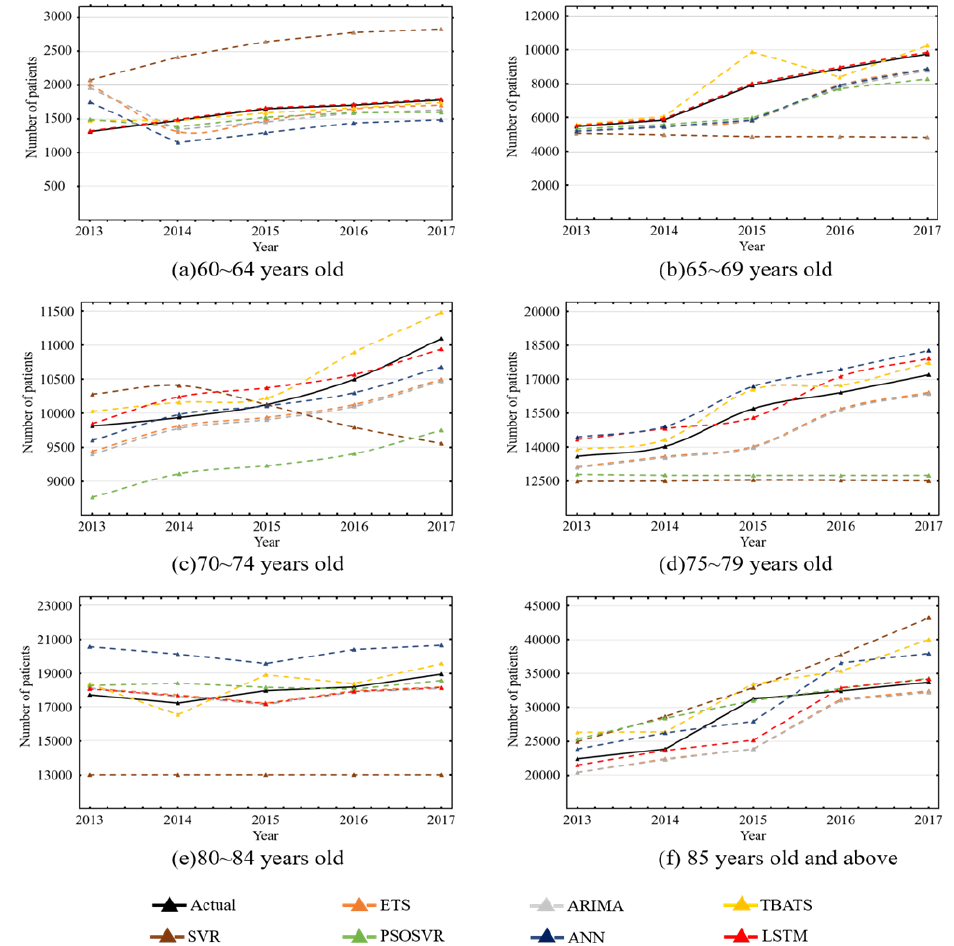
Figure 4. Prediction results of the number of male dementia patients with different models at different age from 2013 to 2017. ( a ) 60~64 years old; ( b ) 65~69 years old; ( c ) 70~74 years old; ( d ) 75~79 years old; ( e ) 80~84 years old; and ( f ) 85years old and